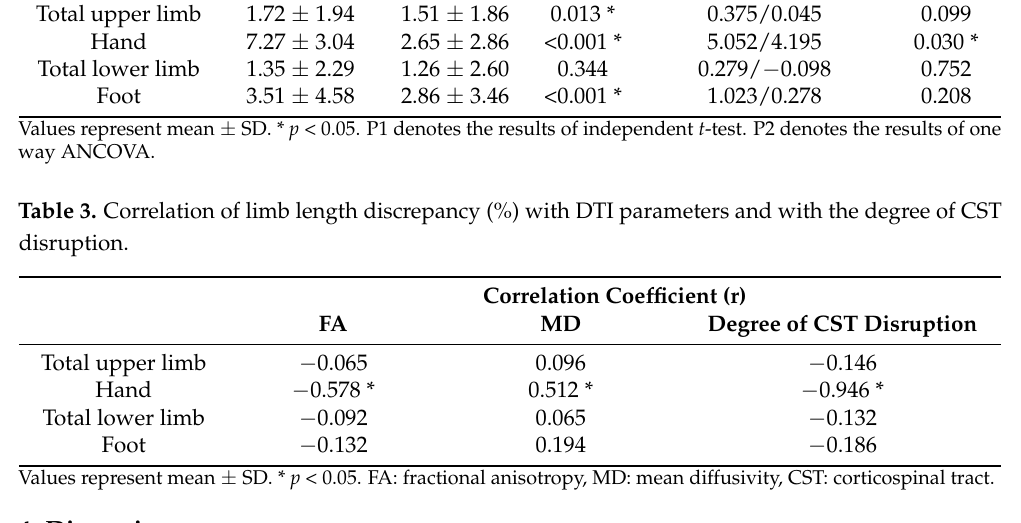
Table 2. Limb length discrepancy (%) between affected side unaffected side in two groups. Group A Group B Discrepancy (%) P1 Difference of 95% CI P2 Total upper limb 1.72 ± 1.94 1.51 ± 1.86 0.013 * 0.375/0.045 0.099 Hand 7.27 ± 3.04 2.65 ± 2.86 <0.001 * 5.052/4.195 0.030 * Total lower limb 1.35 ± 2.29 1.26 ± 2.60 0.344